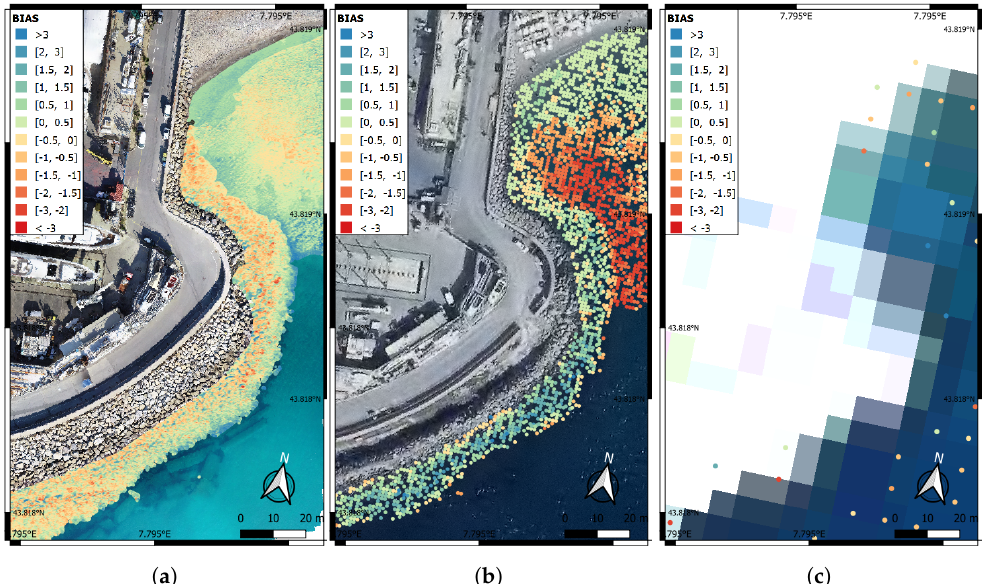
Figure 19. Spatial distribution of the BIAS values of the MBES points for the three RDBs (( a ) UAV, ( b ) aircraft, ( c ) S-2) using blue/red ratios for the sand and rocks classes for all the three images and for natural rocks for the UAV and aircraft orthophotos; the blue/green ratio is used for natural rocks for the S-2 image. The UAV, aircraft and S-2 orthophotos are used as the background. Portosole extended area (beach area